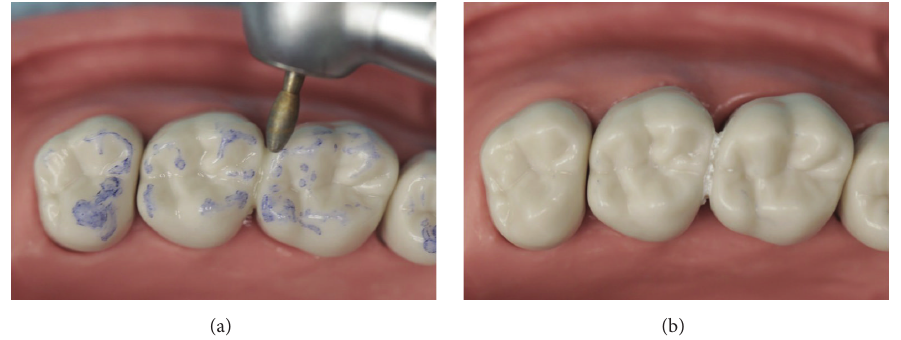
Figure 5: Occlusal adjustment, polish, and finish of the